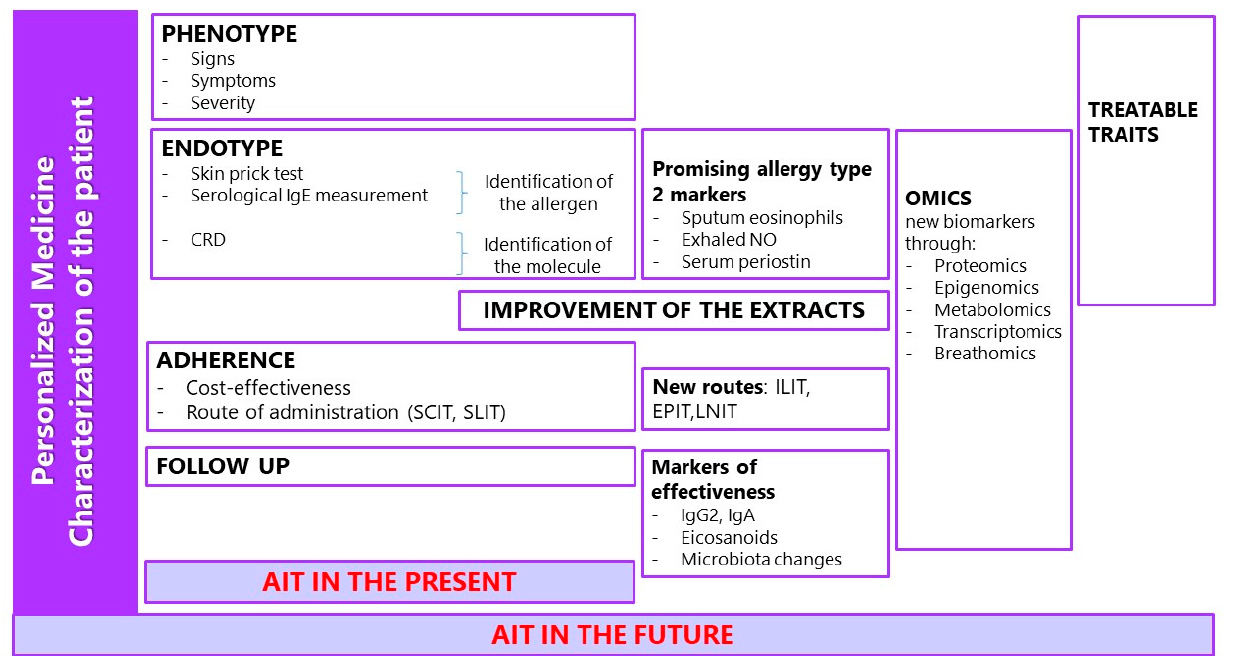
Figure 1. Present and future perspectives of personalized medicine in allergen immunotherapy (AIT). Abbreviations: CRD, Component Resolved Diagnosis; NO, nitric oxide; SCIT, subcutaneous immunotherapy; SLIT, sublingual immunotherapy; ILIT, intralimphatic immunotherapy; EPIT, epicu- taneous immunotherapy; LNIT, local nasal